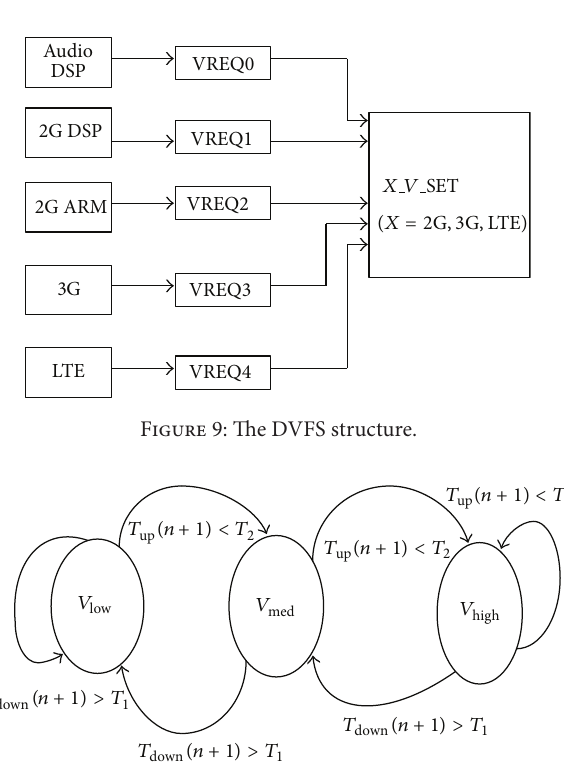
Figure 10: The intelligent transition for